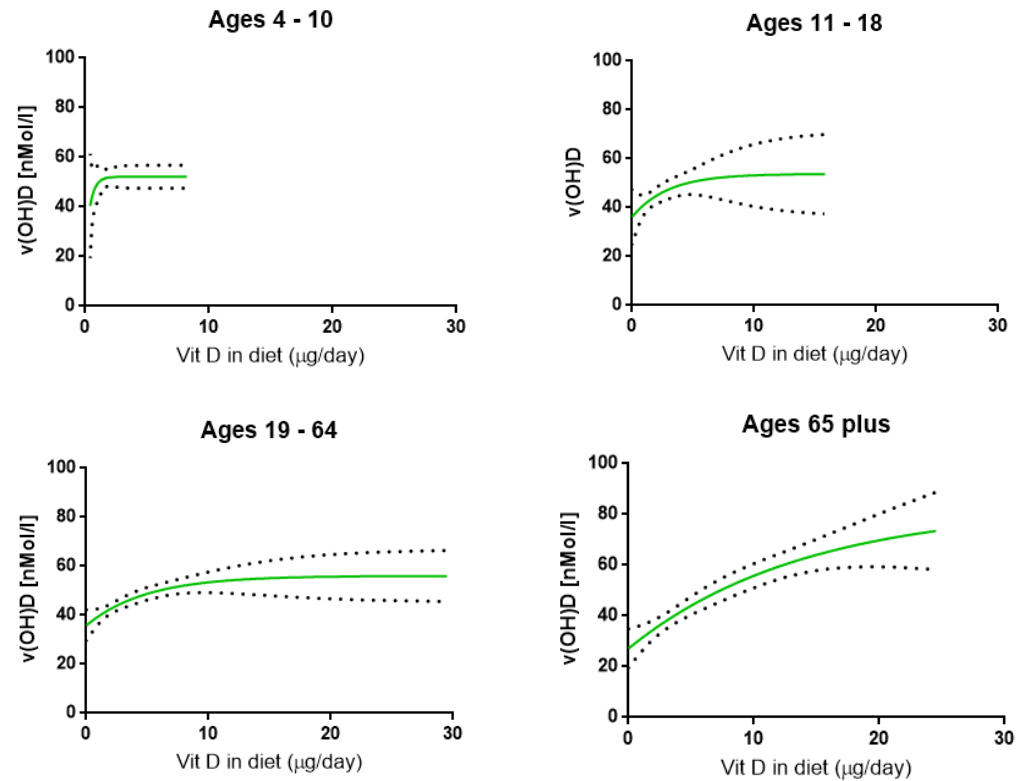
Figure 1. The association between the vitamin D in diet ( µ g per day) and the serum concentration of 25(OH)D (nmol / L) as observed in the NDNS database. The solid line represents the 50% relationship while the dotted lines show the 95% CI level.